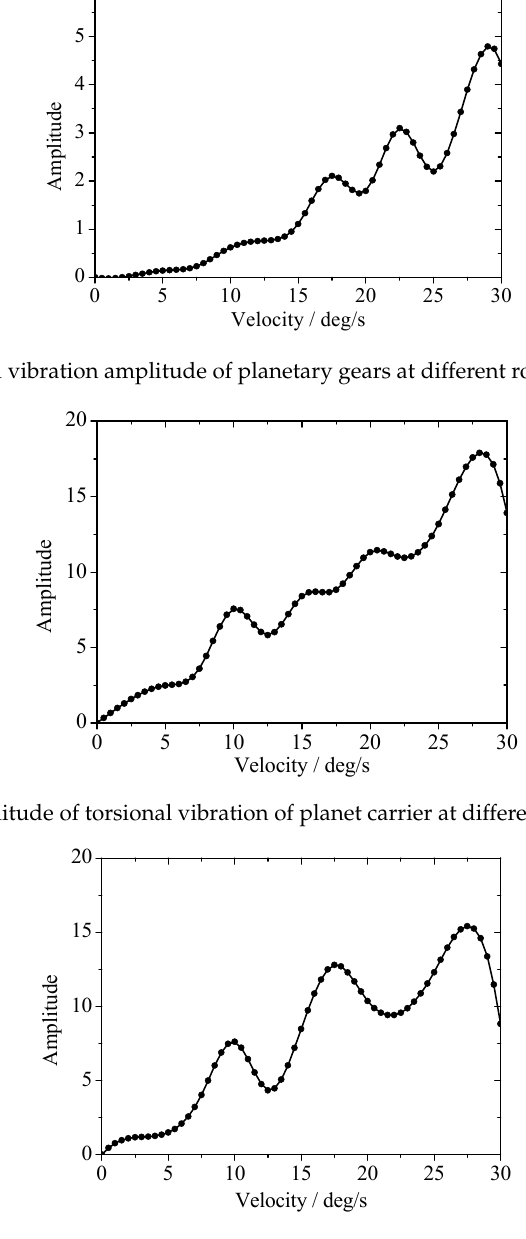
Figure 11. The amplitude of torsional vibration of planetary gears at different rotational velocities.